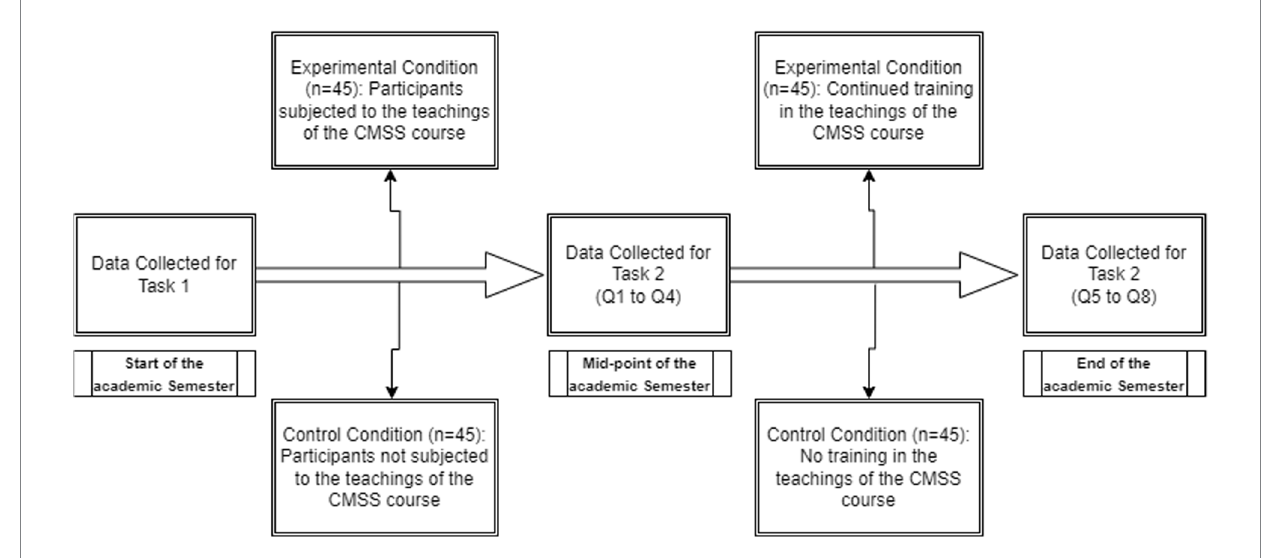
FIGURE 3 Research schema outlining the experimental design and methodology employed in the study.